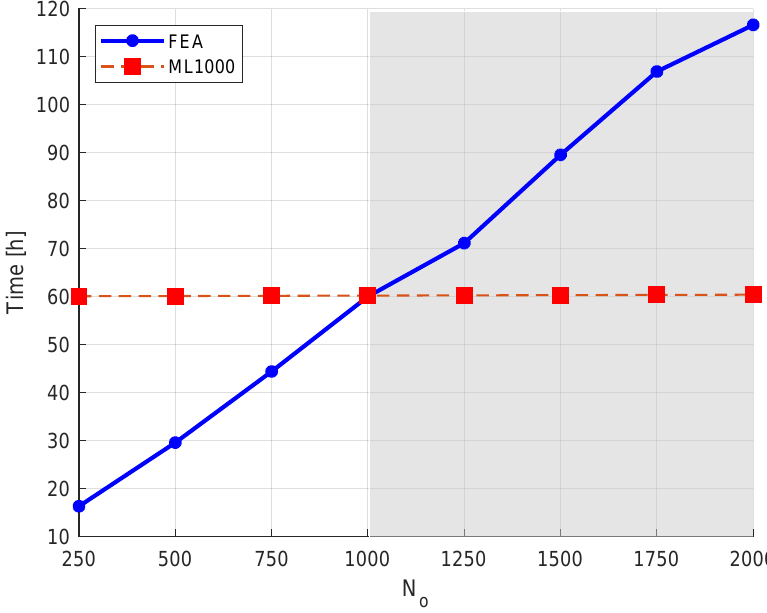
Figure 10. Machine learning model vs. FEA computational costs. The computational time is identified with blue for the FEA case and with red for the ML1000 model. For the machine learning model, the computation time consists of both time spent building the machine learning model and the time required for optimisation.